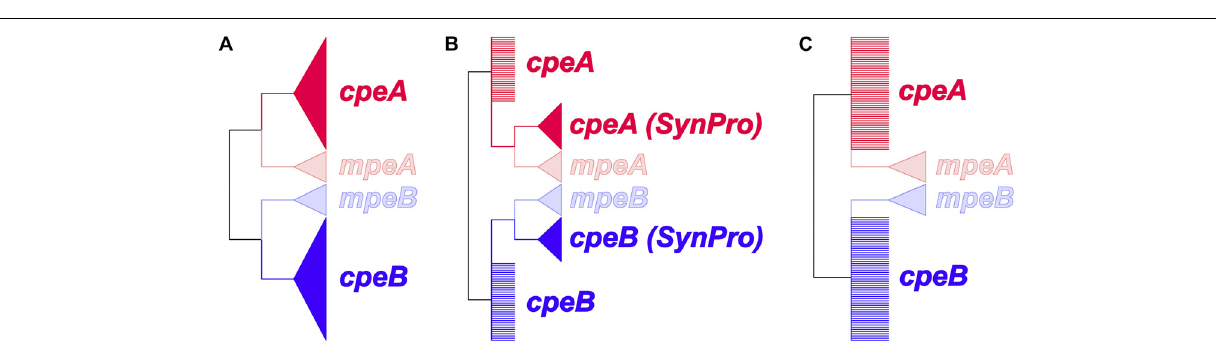
FIGURE 3 | Prior constraints for the hypotheses to identify the evolutionary mechanism leading to the divergence of mpeA and mpeB from cpeA and cpeB . Wedges represent monophyletic groups; polytomies are represented as multiple branches arising from a single node. (A) Duplication or lateral gene transfer (LGT) before the last common ancestor of Cyanobacteria. cpeA and cpeB are constrained to form a monophyletic clade excluding, respectively, mpeA or mpeB . (B) Duplication in a common ancestor prior to the diversification of S. spongiarum and of picocyanobacterial lineages. The cpeA (Syn/Pro) and cpeB (Syn/Pro) clades contain the sequences for the respective gene, from all the picocyanobacteria (including S. spongiarum ). (C) Lateral gene transfer between a crown group cyanobacterium and a common ancestor of S. spongiarum and the other Synechococcus species that possess mpeBA genes. This hypothesis, unlike (A) , does not constrain cpeA and cpeB sequences to form monophyletic clades excluding, respectively, mpeA or mpeB